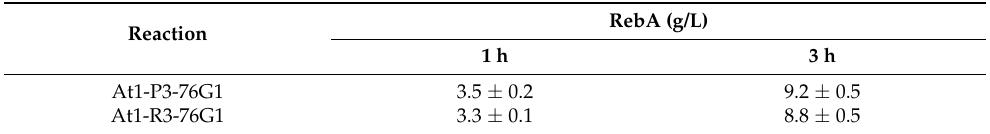
Figure 2. The influence of different types of linkers on the yield of RebA. The reaction mixture (20 mL), consisting of approximately 3 mg/mL of the crude extract, 20 g/L stevioside, and 60 g/L sucrose, was incubated at pH 7.2 and 30 °C for 16 h. Table 4. The influence of P3 and R3 linkers on RebA production.